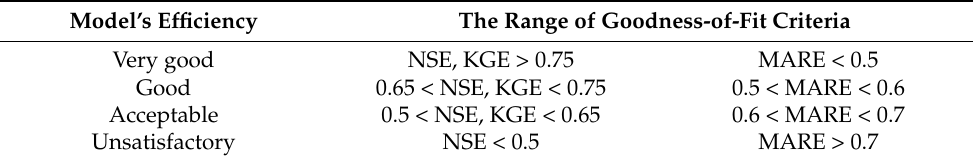
Table 5. Model’s efficiency in terms of goodness-of-fit